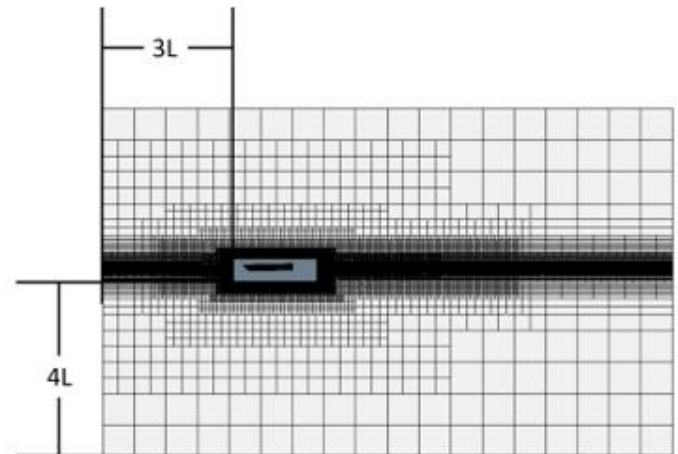
Figure 7. Location of the overset region (shown without mesh) within the background region. The background region can translate forward, and the overset region can translate/rotate in 3 degrees of freedom. The hull surface is shown in black.